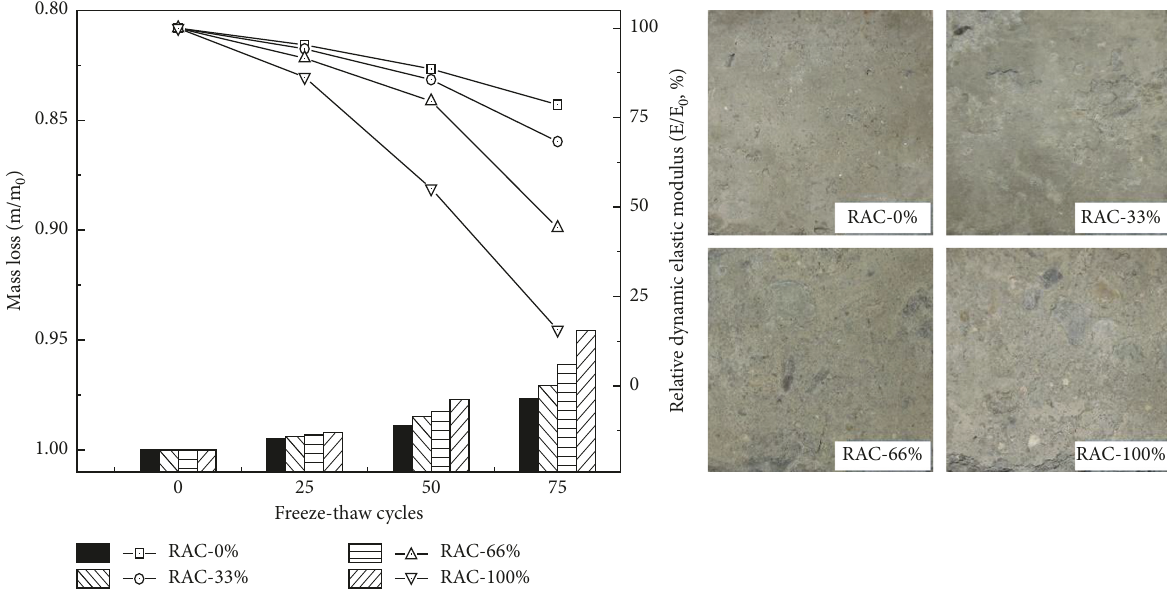
Figure 6: Mass loss and relative dynamic elastic modulus of RAC after freeze-thaw